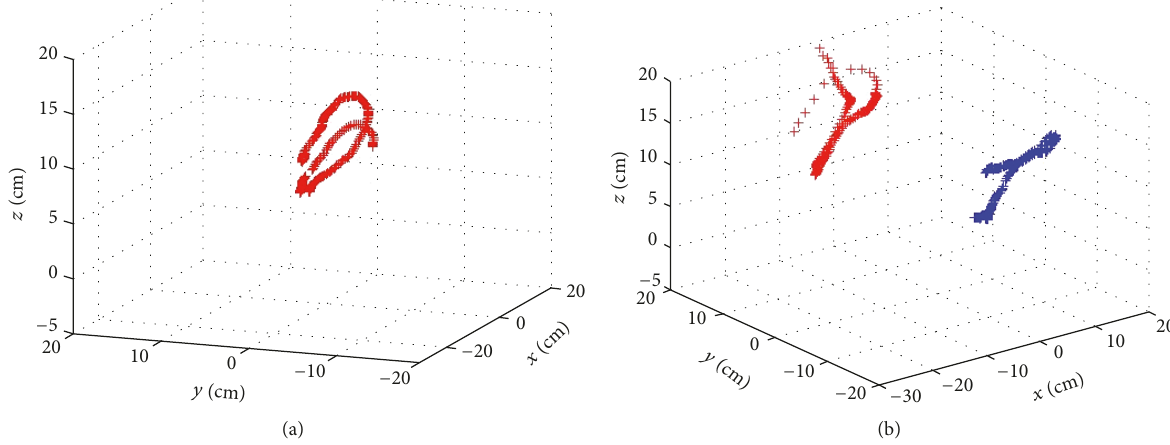
Figure 12: Examples of reconstructed 3D trajectory of a single-hand (a) and the multiple hand movements (b).